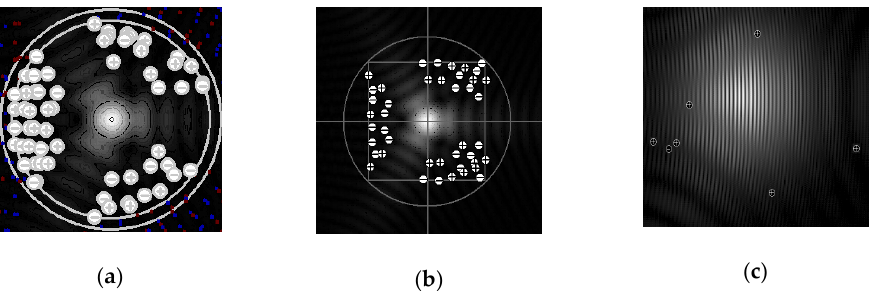
Figure 8. Distributions of singular points in a beam with a phase profile set by polynomial No. 8 (coma). The dislocations are shown by circles with «+» or « − » signs. To register optical vortices three algorithms were used. Firstly, vortices were localized by processing distribution of wavefront gradients ( a ); secondly, as a point of intersection of isolines ( b ); and with application of interfero- metric algorithm ( c ). The number of the found singular points N dsl = 98 ( а ), N dsl = 92 ( b ) и N dsl = 10 ( c ). The normalized path length was equal to 0.1.